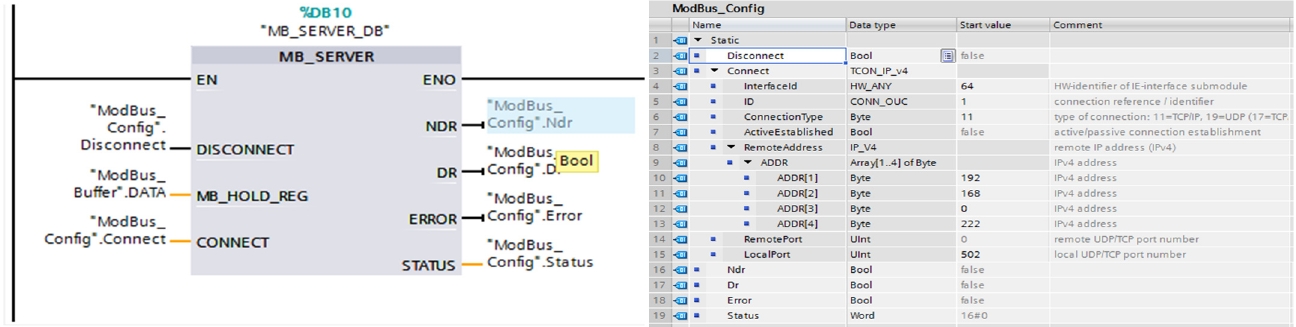
Figure 22. Siemens Modbus Server configuration in Main PLC.